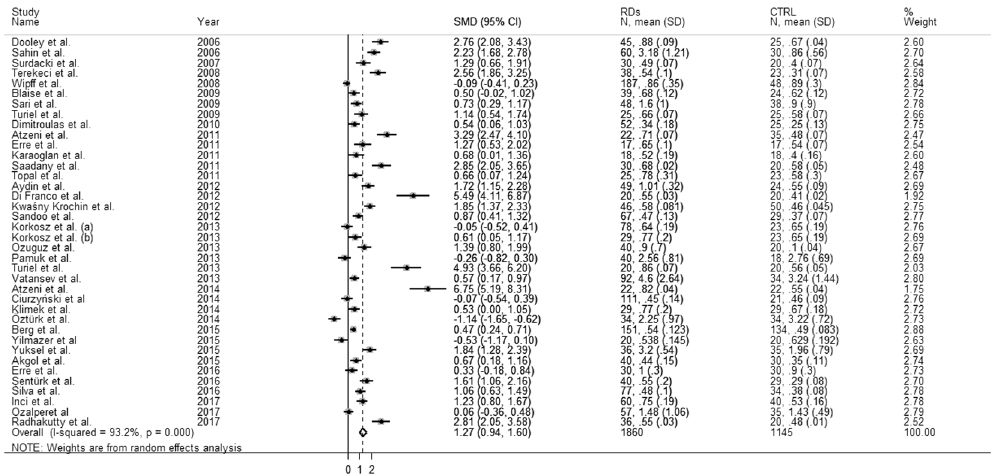
Figure 2. The pooled standard mean difference (SMD) for asymmetric dimethylarginine (ADMA) concentrations with 95% confidence intervals for eligible